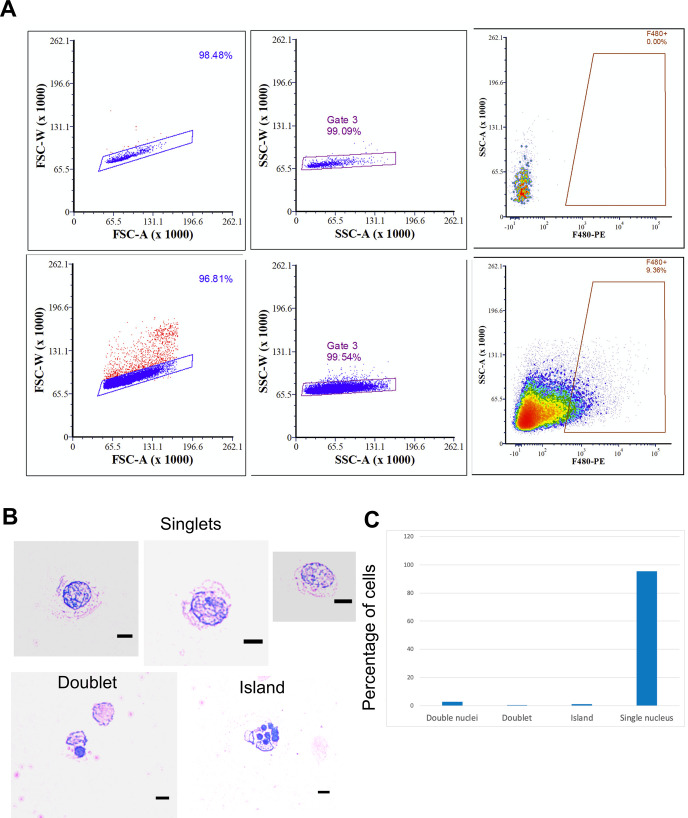
Isolation of a pure population of F4/80+ E13.5 fetal liver cells by FACS.(A) Gating strategy used to stringently sort singlets that are F4/80+ is shown from unstained (no antibody [Ab]) or treated (anti-F4/80 Ab) fetal liver cells from EKLF+/+ E13.5 fetal livers. (The same approach was used for EKLF-/- cell sorting in Figure 3A.) (B) FACS-sorted cells using the strategy above were cytospun on a slide and observed after May-Grunwald-Giemsa staining for singlets, doublets, or >3 cells. 25 µm scale bars are indicated. (C) Quantification of data from (B) (source data: Figure 1—figure supplement 1—source data 1 ).Figure 1—figure supplement 1—source data 1.Quantification of cells isolated by FACS sorting F4/80+ macrophages from E13.5 fetal liver after cytospin.